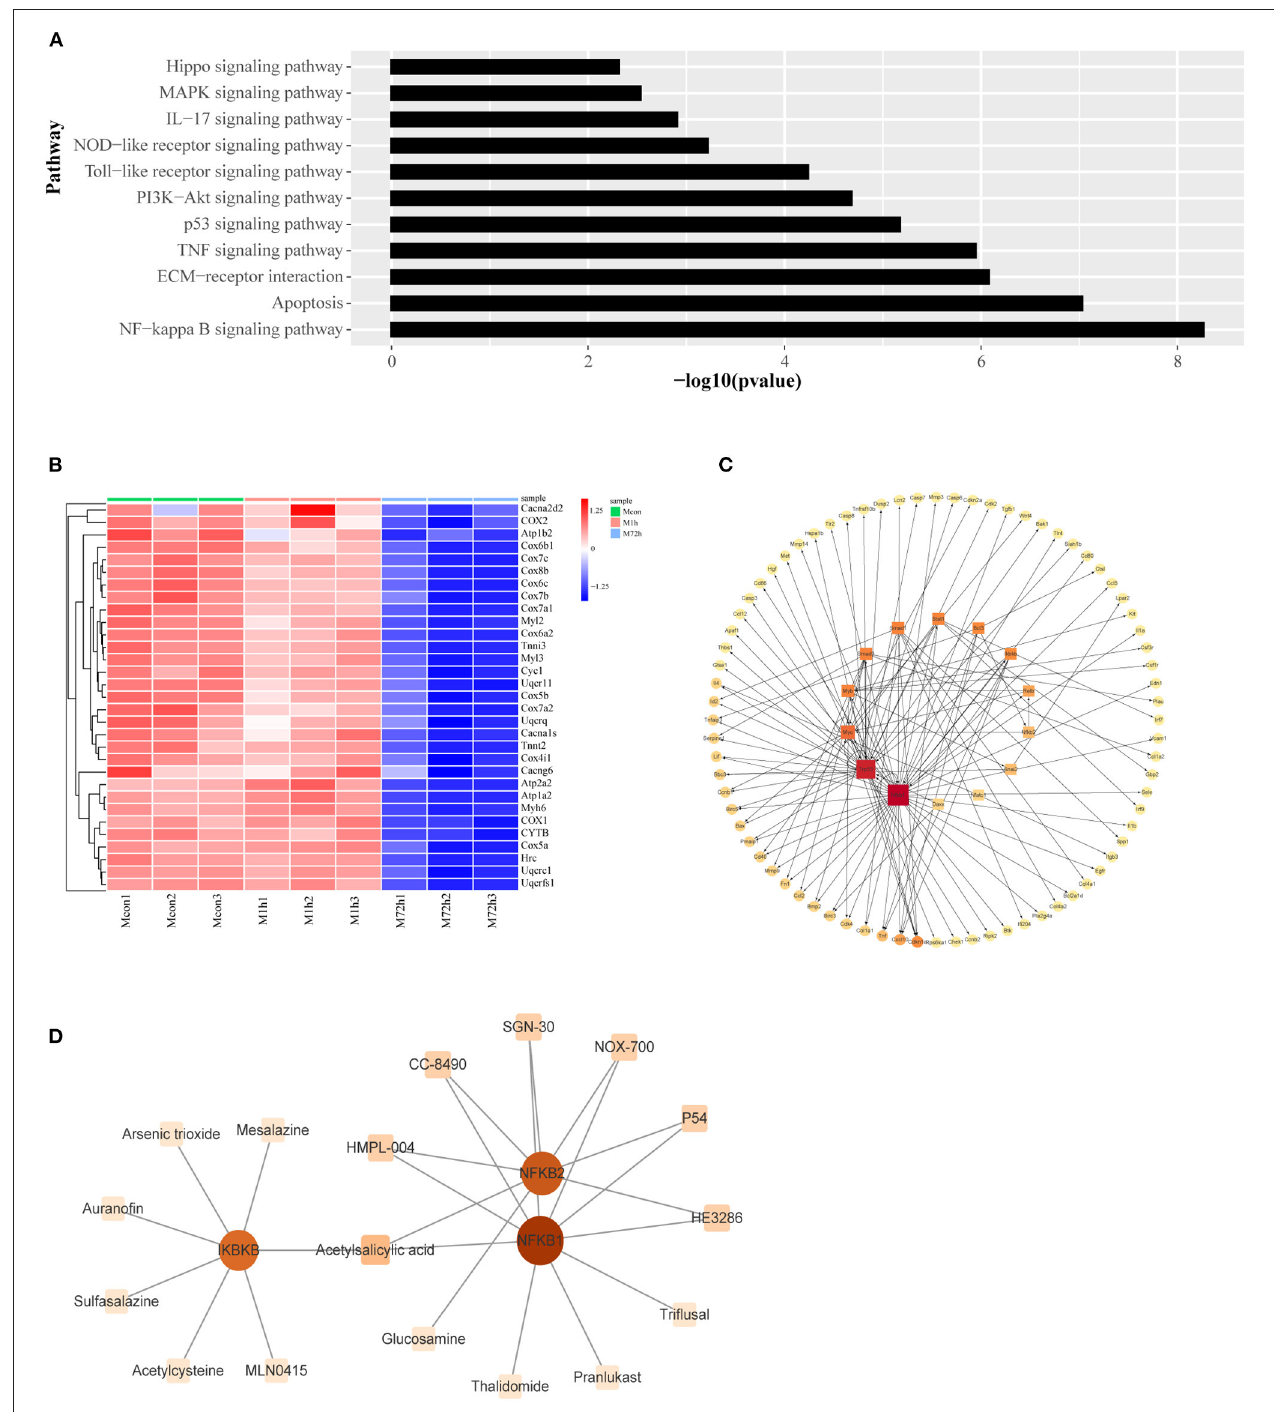
FIGURE 6 | (A) Signaling pathways associated with apoptosis and inflammation in type I profiles (profiles #4 and #7). (B) Heatmap of genes associated with cardiac muscle contraction. (C) The transcriptional regulatory network of genes related to apoptosis and inflammation. The square nodes represent the transcription factors, the circular nodes represent the target genes, the node size represents node connectivity, and the arrow represents the regulatory direction. (D) Protein–drug interactions. The square nodes represent the drugs, the circular nodes represent the genes.